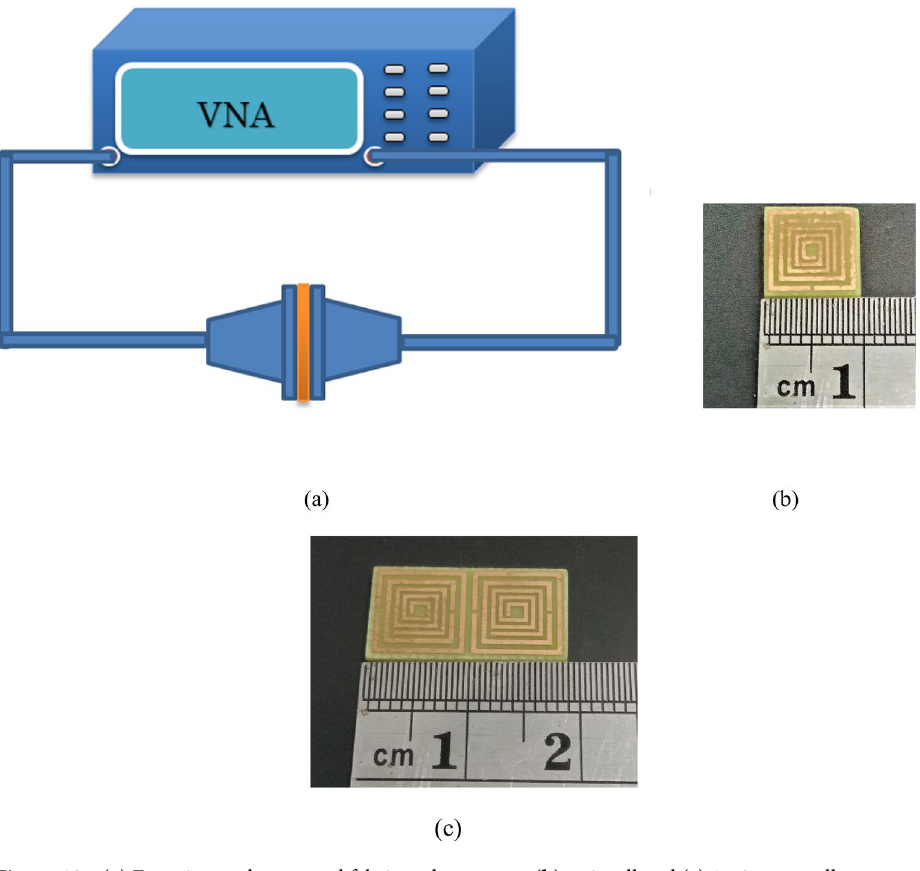
Figure 10. ( a ) Experimental setup and fabricated prototype ( b ) unit cell and ( c ) 1 × 2 array cell.